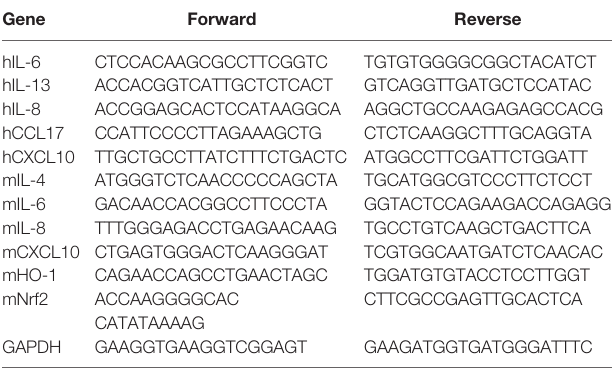
TABLE 2 | Primer sequences for quantitative real-time polymerase chain reaction (qPCR).